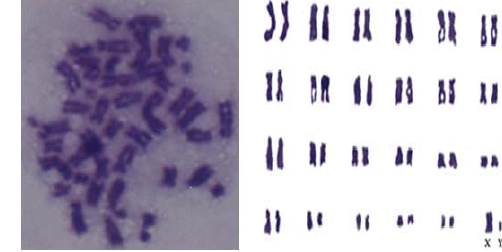
F IGURE 9. Metaphase spread and idiogram of Dryomys